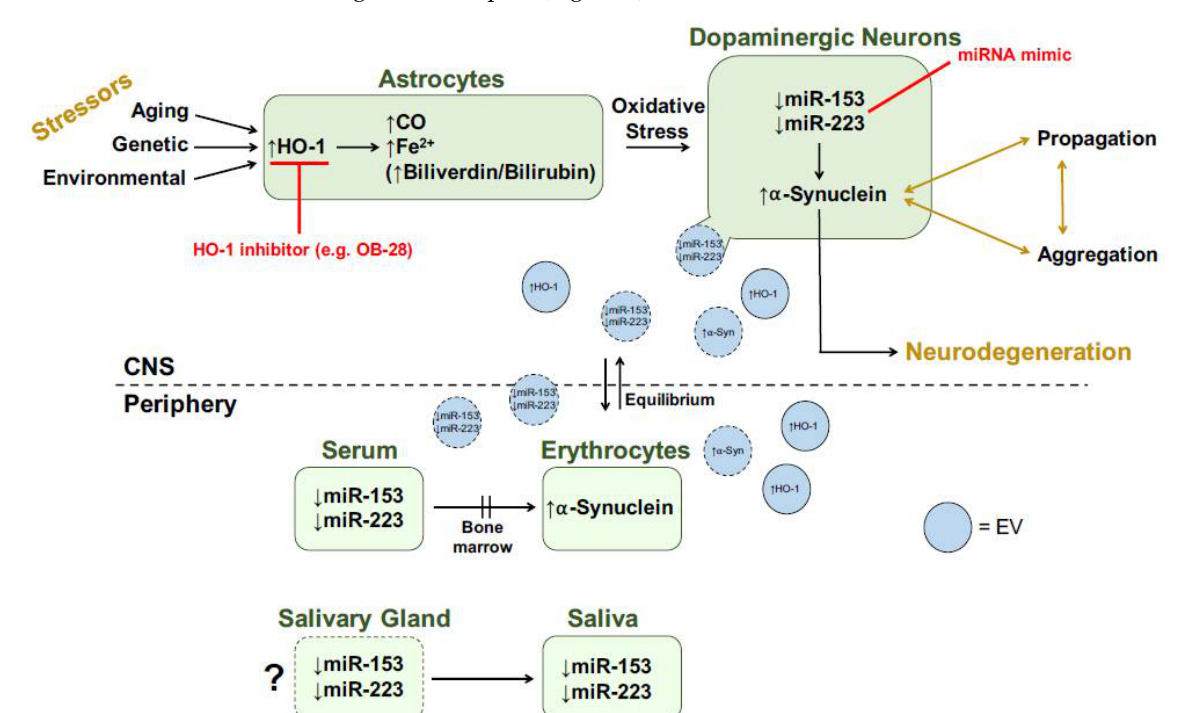
Figure 5 . Transducer model for role of HO-1 in PD. Red text denotes potential therapeutic strategies. Shapes with dotted borders represent speculative hypotheses. See text for more details. CNS, central nervous system; CO, carbon monoxide; EV, extracellular vesicle; Fe 2+ , ferrous iron; HO-1, heme oxygenase-1; miRNA, microRNA; α-Syn, α-synuclein. Modified from [64].